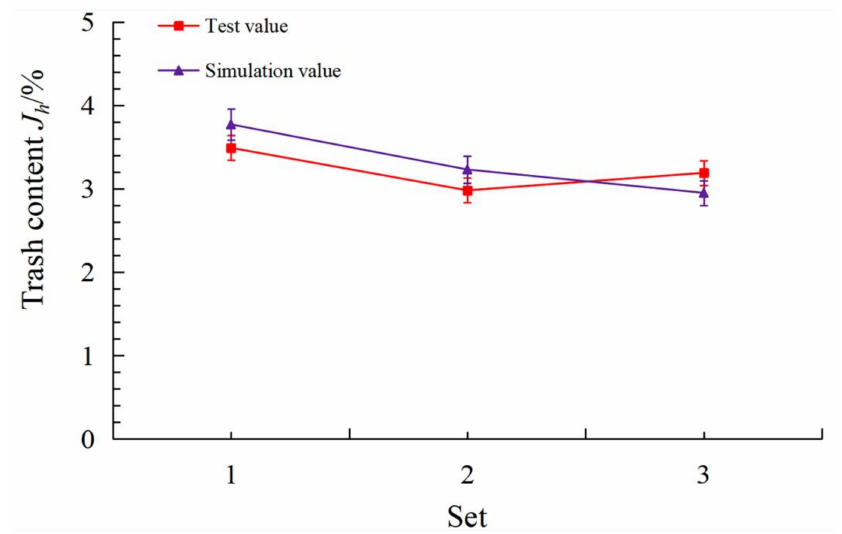
Figure 17. The verification results of simulation value and test